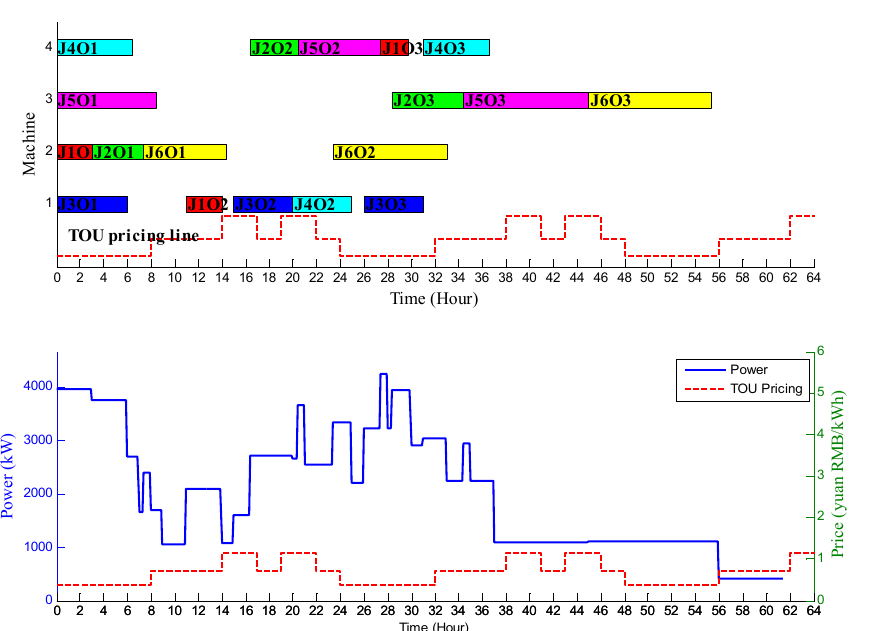
Figure 10. Gantt and power charts of the optimal solution to configuration C4 × 6&PSV.